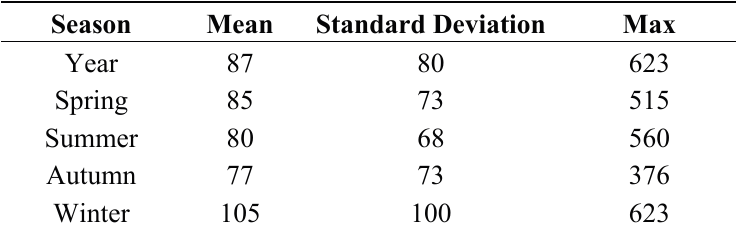
Table 2. Summary statistics for PM 2.5